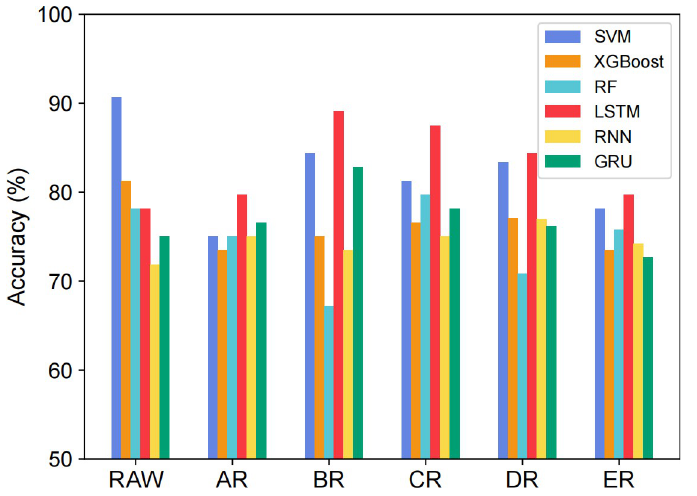
Fig 8. Accuracy comparison of LSTM and contrast models using different